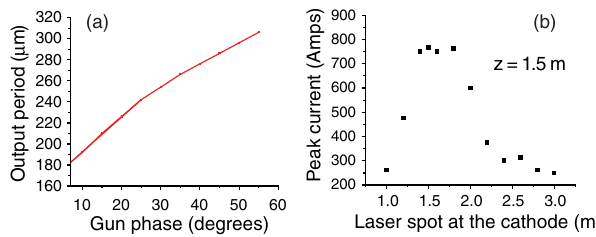
FIG. 7. (a) Peak of bunching factor at the gun exit as a function of laser injection phase showing compression and stretching of the modulation. (b) Peak current at z ¼ 1 : 5 m after 1 = 2 plasma oscillation as a function of input laser spot